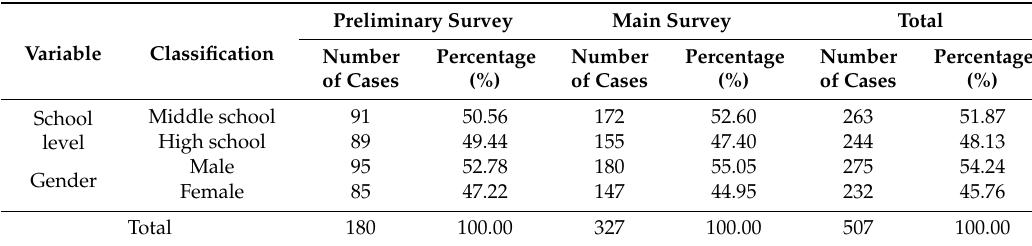
Table 1. General characteristics of the participants.